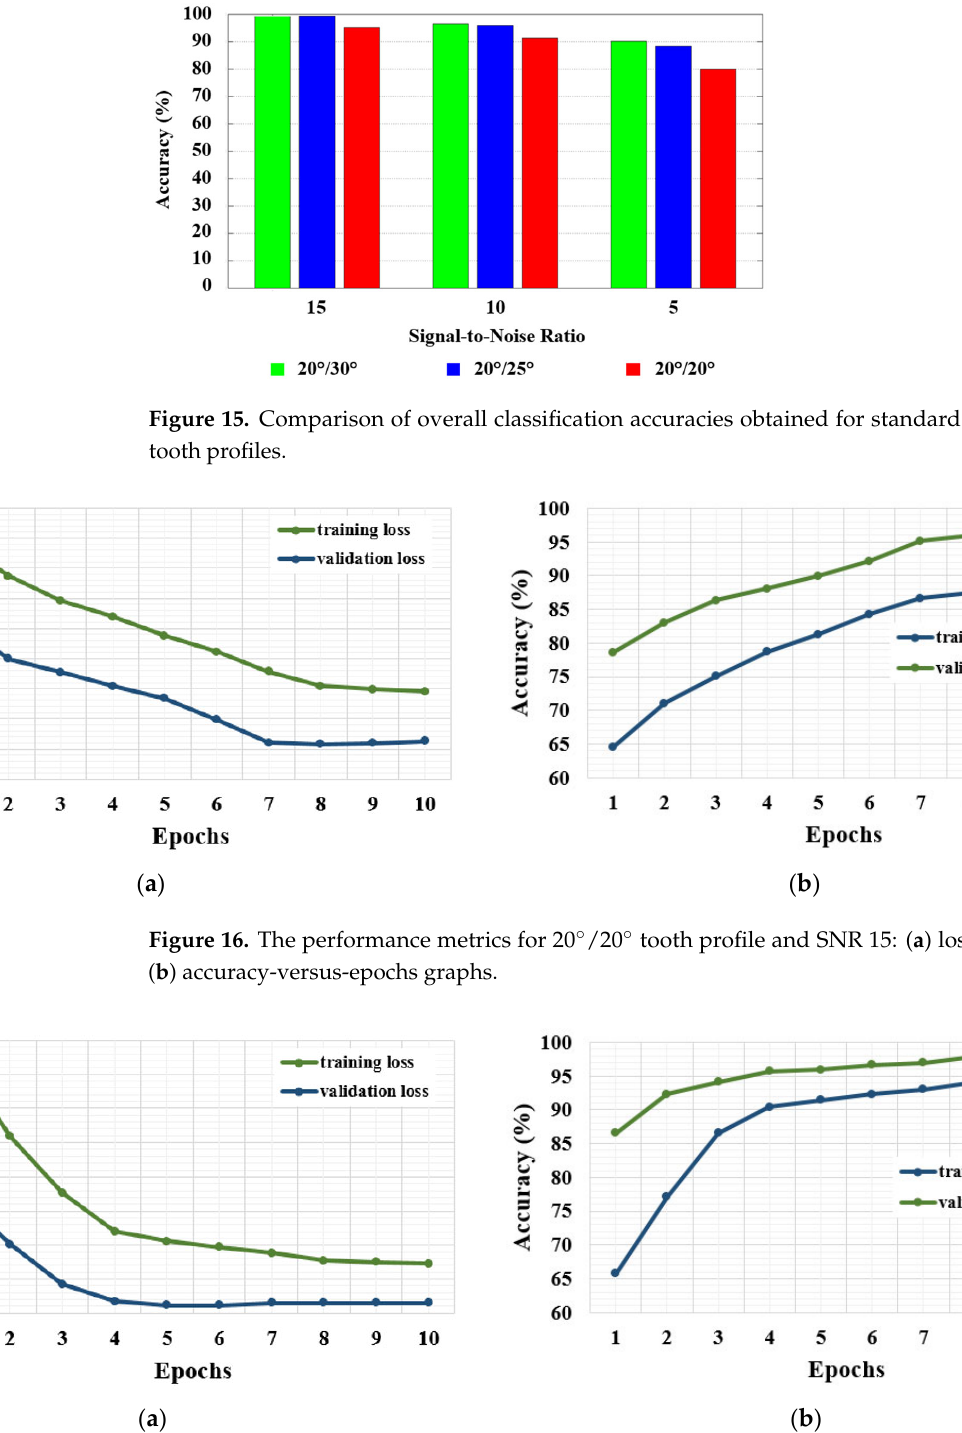
Figure 17. The performance metrics for 20°/25° tooth pro fi le and SNR 15: ( a ) loss-versus-epochs; ( b ) accuracy-versus-epochs graphs.